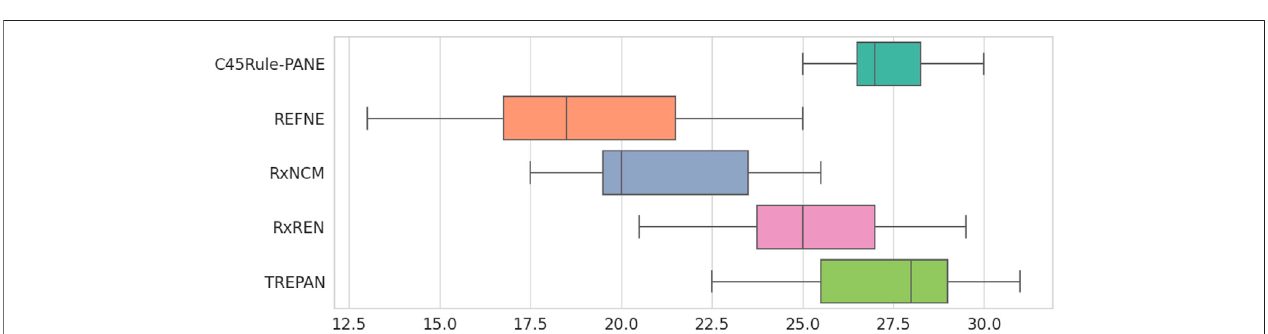
Frontiers in Arti fi cial Intelligence |